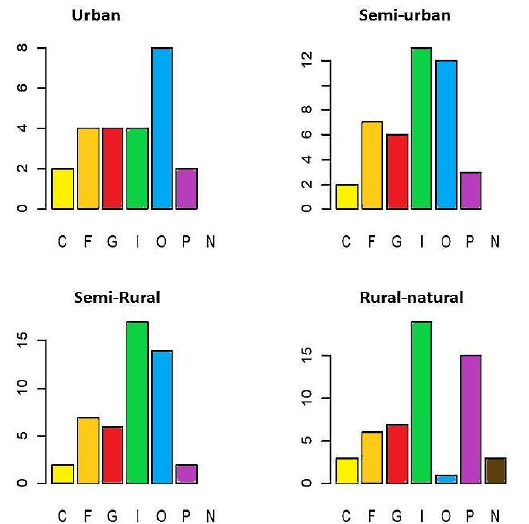
Fig. 3. Feeding guild of birds along rural-urban gradients sites in Aligarh, Uttar Pradesh (C=Carnivore, F=Frugivore, G=Granivore, I= Insectivore, N= Nectivore, O=Omnivore, P=Piscivore) Table 2. Bird community structure at various sampling sites in Aligarh, Uttar Pradesh, India Density Sampling sites Families Species Richness Diversity Evenness (Birds/hectare)